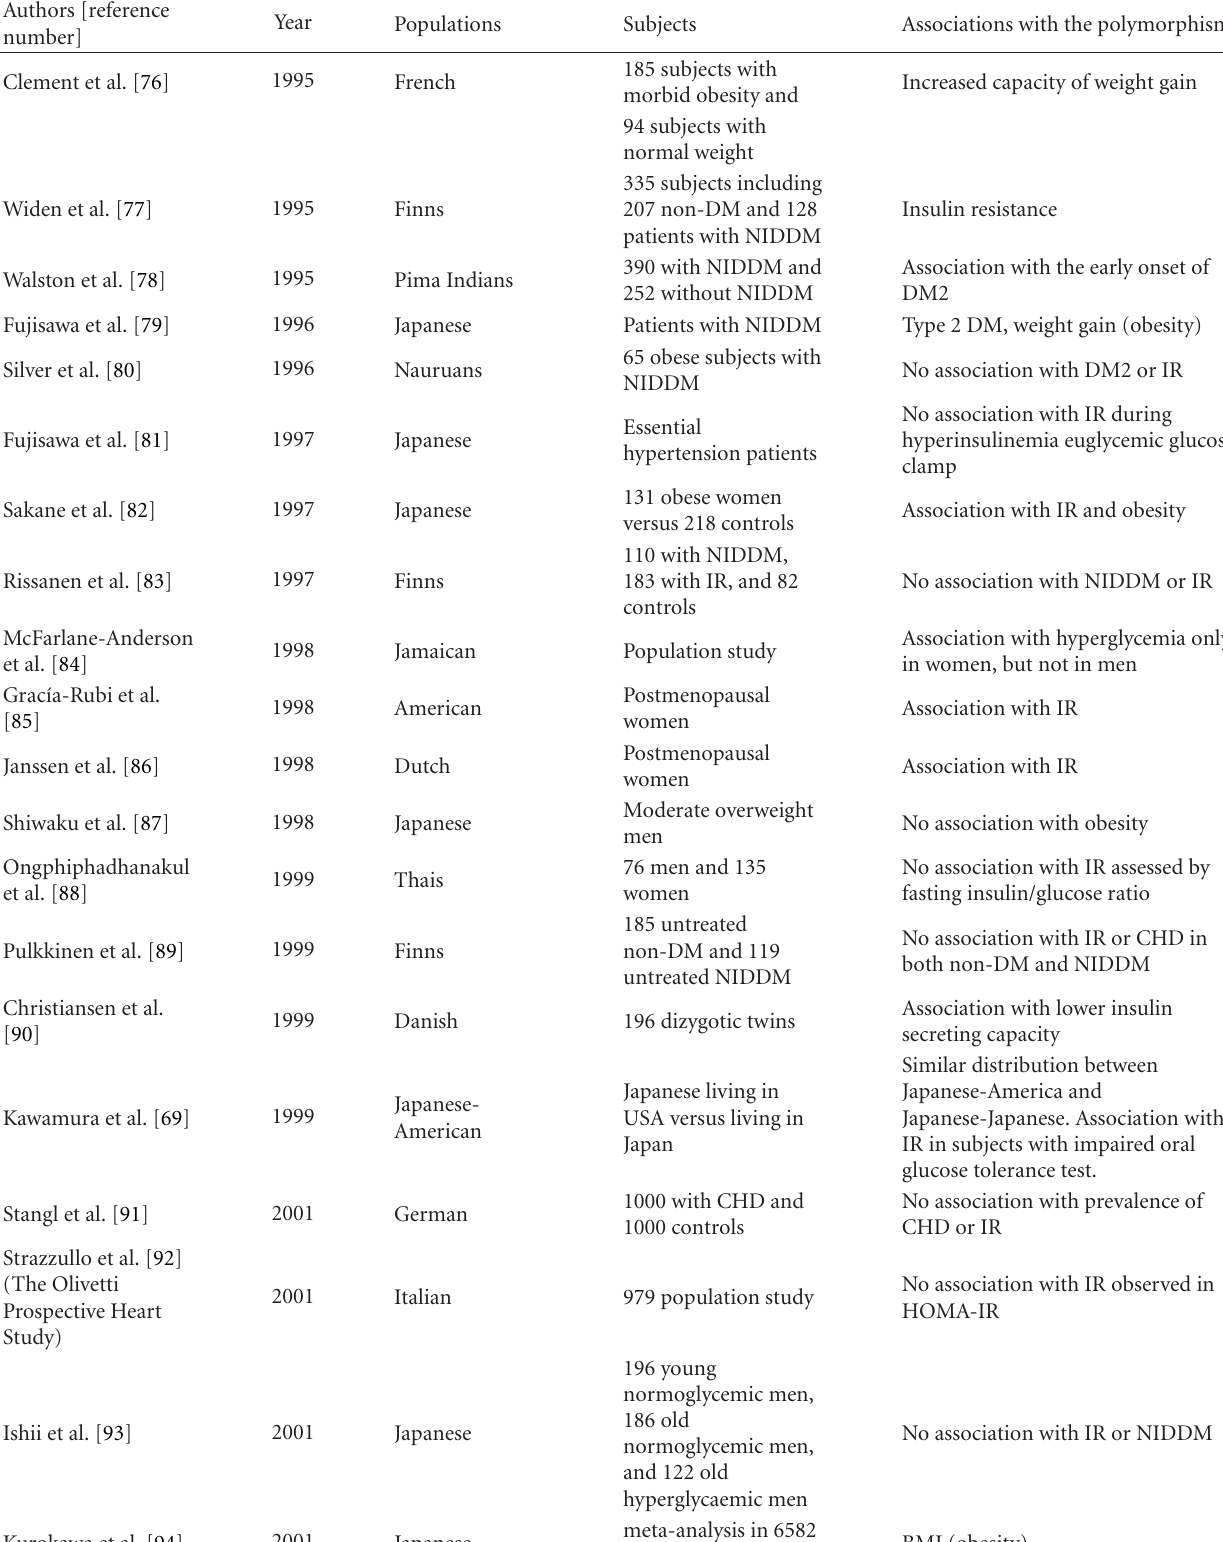
Table 4: Trp64Arg, β 3-adrenoceptor polymorphisms: association with hypertension, metabolic syndrome (type2 diabetes (DM)), and